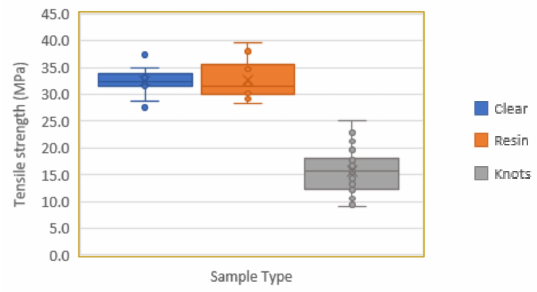
Figure 29. Tension strength.